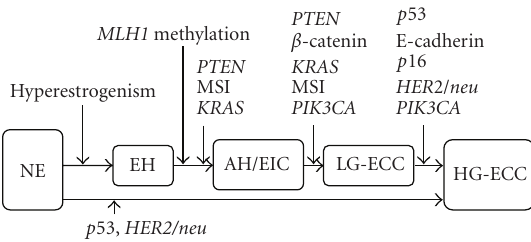
Figure 2: A progression model for endometrioid